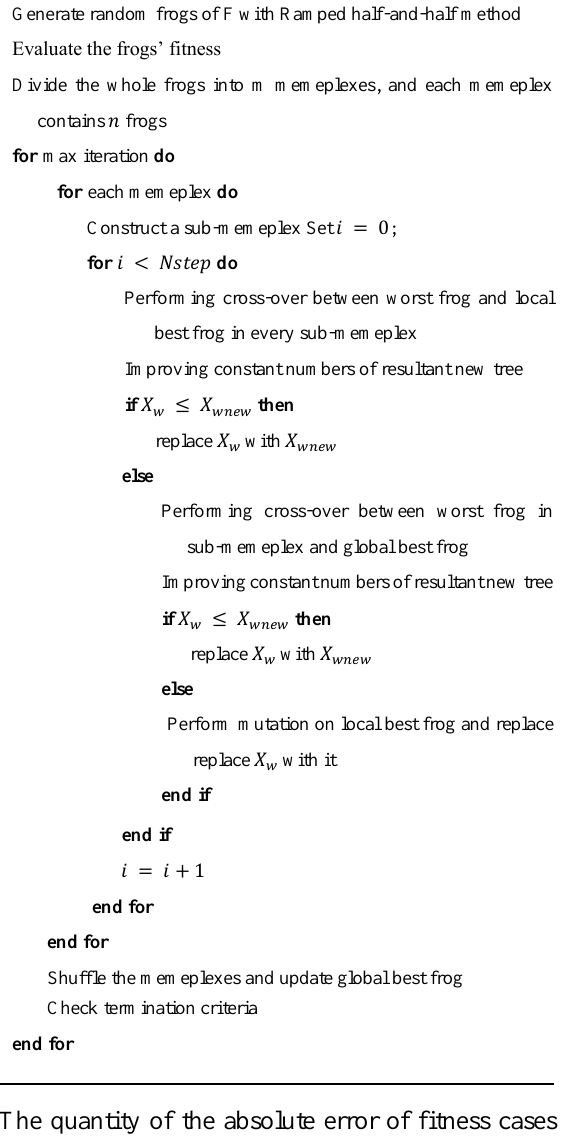
Algorithm 1: Pseudo-code of